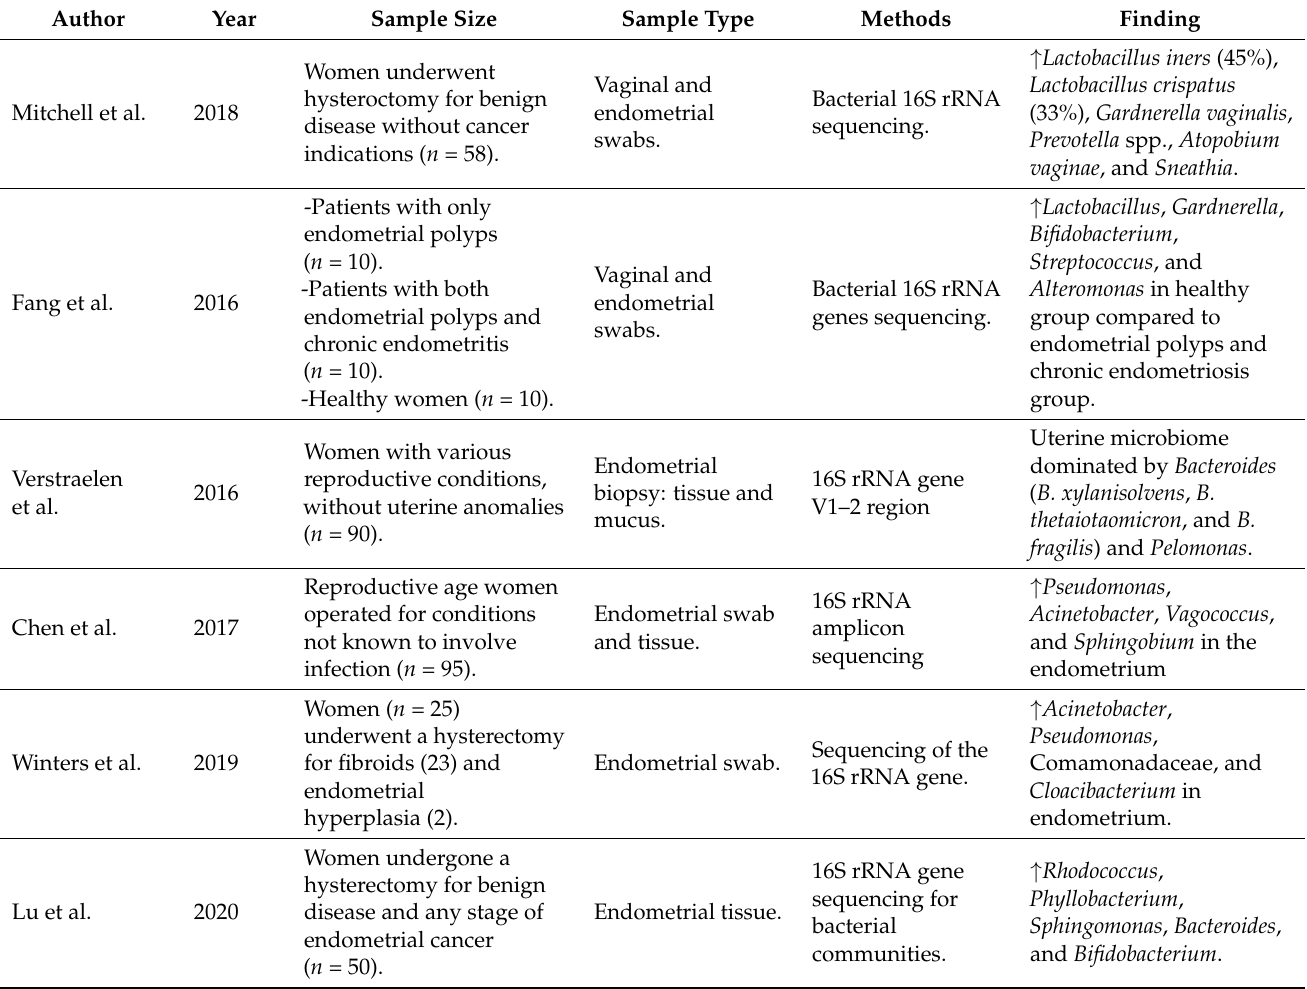
Table 1. Endometrial microbiome characterization